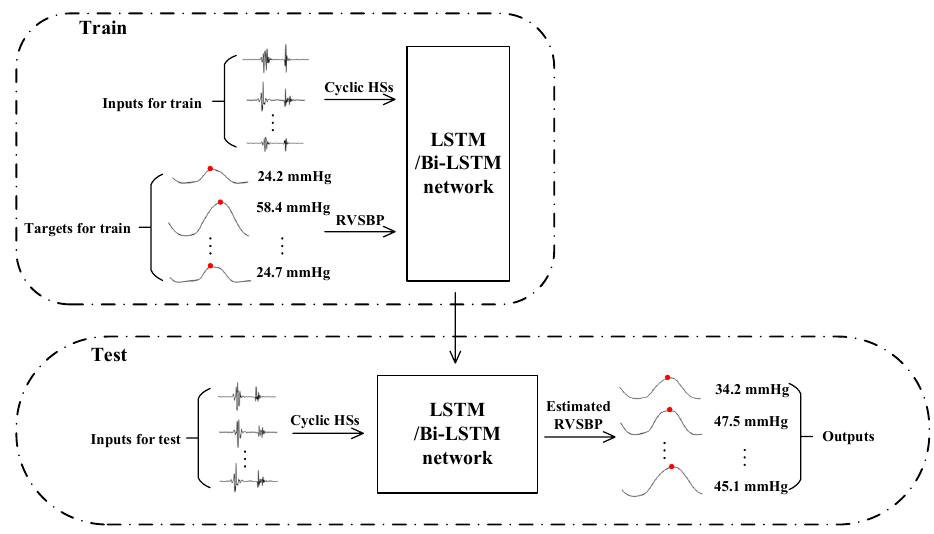
Figure 6. Framework of the proposed technique.